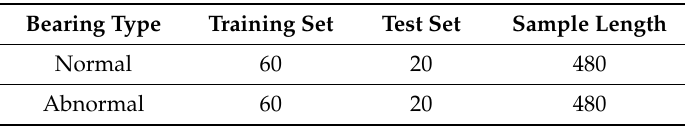
Table 1. Experiment